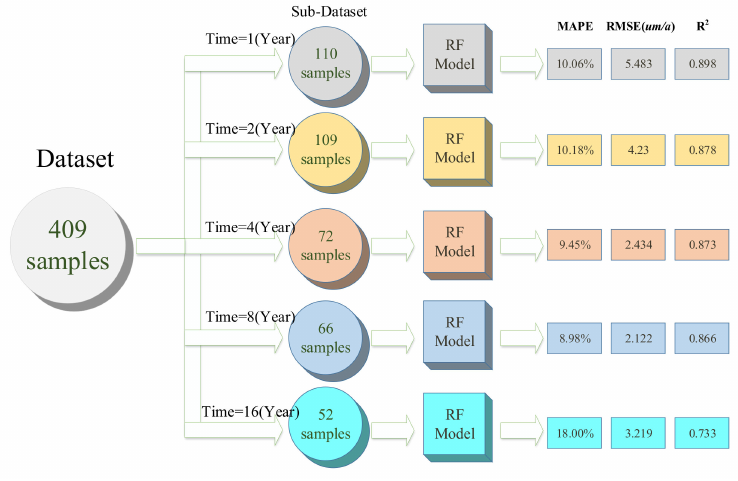
Figure 7. The process and the validations of the five different RF models for different